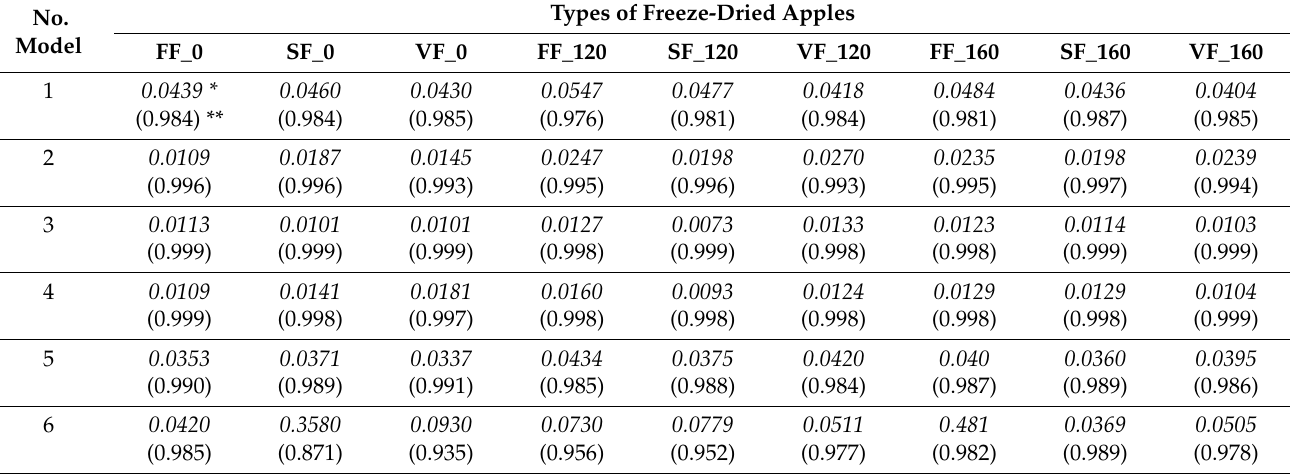
Table 4. The statistical results ( R 2 , RMSE ) of fitting to drying models (1–6) for different freeze-dried apples.